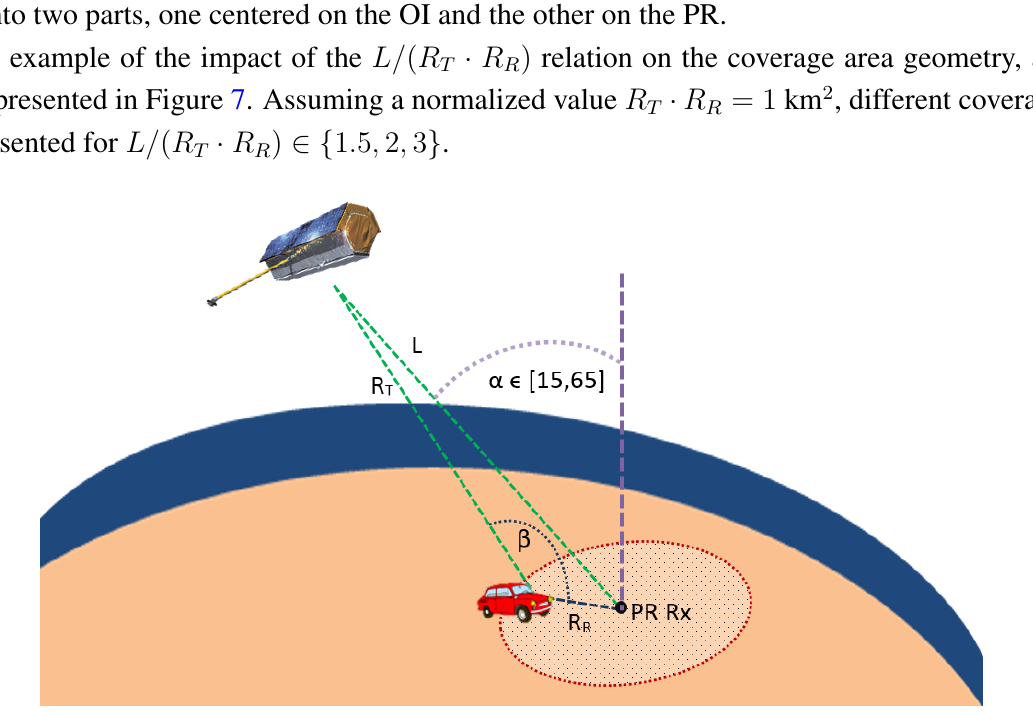
Figure 6. Geometry of the PAZ-based passive radar: β is the bistatic angle and α is the incidence